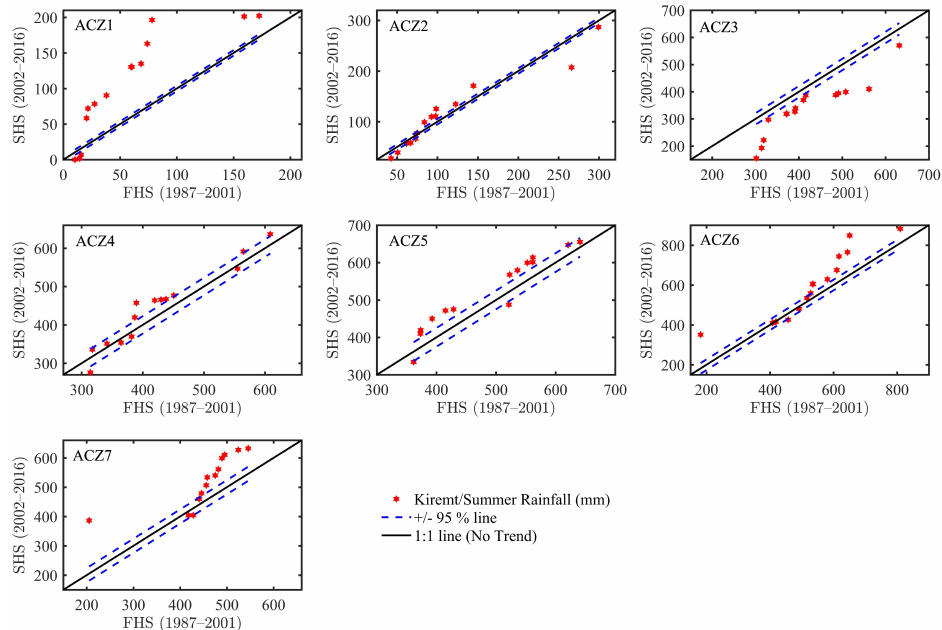
Figure 9. Kiremt/Summer rainfall trend using the ITA method.